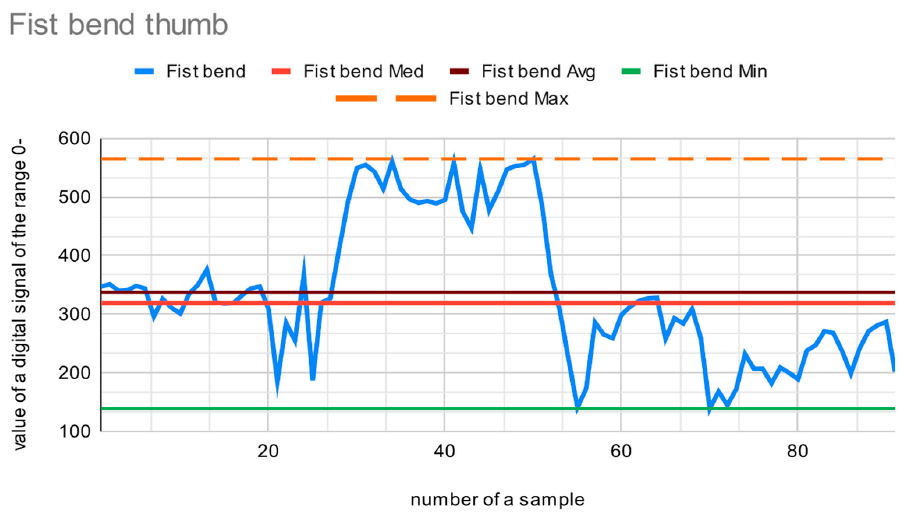
Figure 12. Data from the sensor on a maximally bent thumb.